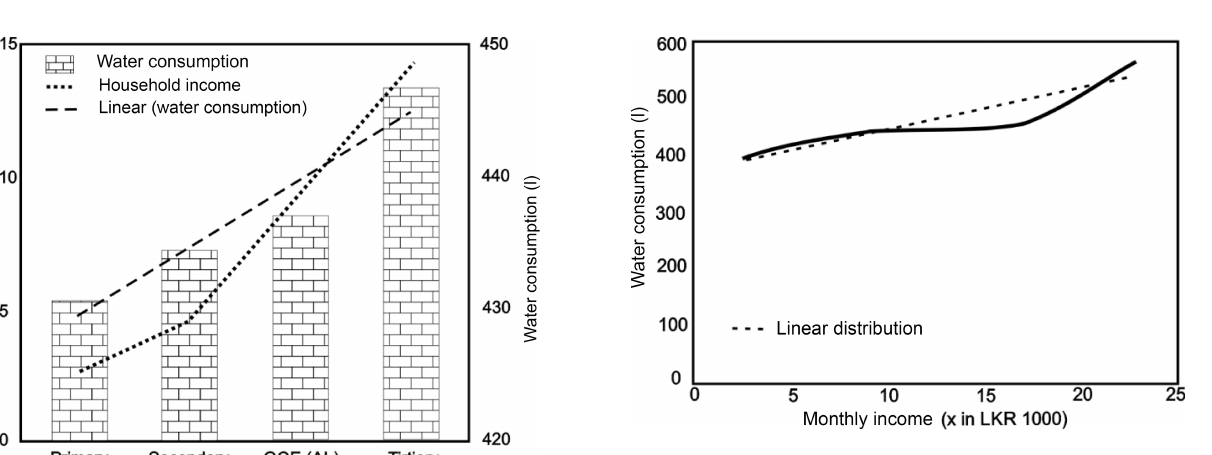
Figure 3. Monthly household income vs. daily water consumption.